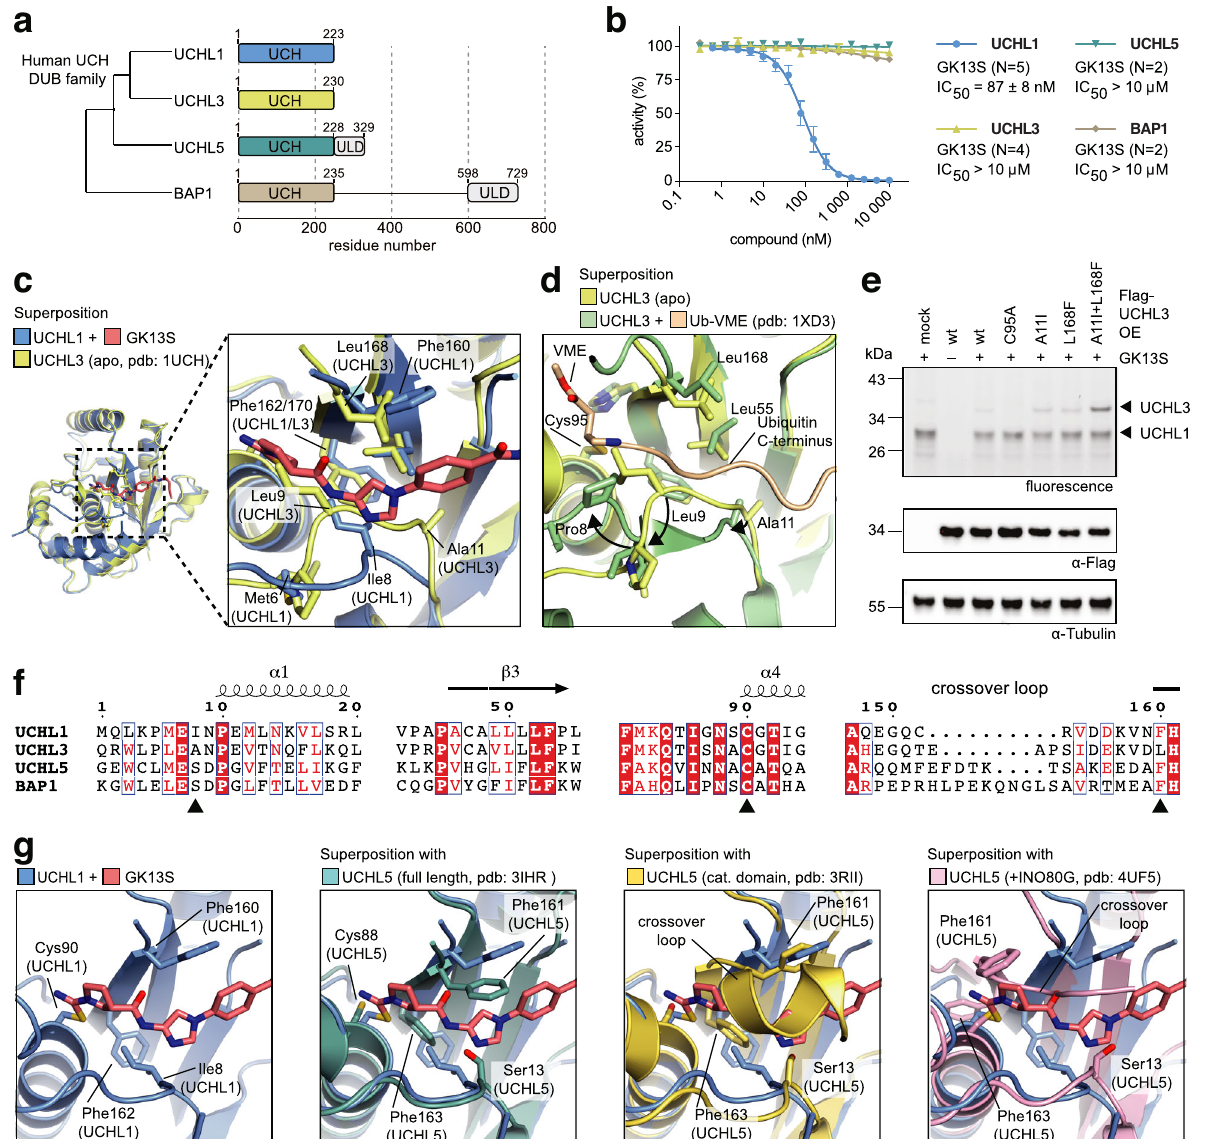
Fig. 6 | Structural basis for speci fi c inhibition of UCHL1. a Average distance alignment and schematic representation of domain architecture of human UCH family deubiquitinases. Boundaries of bacterially expressed UCH catalytic domain constructs are given. ULD, UCH37-like domain. b Ubiquitin rhodamine cleavage assayof indicated recombinant UCH DUBs, preincubated with GK13S dilutions for 1h. Data points are shown as mean±standard error from N =2 – 5 independent experiments, as indicated in the fi gure. Source data are provided asa Source Data fi le. c Superposition of UCHL1~GK13S with apo UCHL1 (pdb: 2ETL) and apo UCHL3 (pdb: 1UCH) and close-up view of the binding pocket. Labeled residues are shown assticks. d Superpositionoftheequivalenttothecompoundbindingpocketinapo UCHL3 and UCHL3~Ub-VME (pdb: 1XD3). The Ubiquitin C-terminus is shown in cartoon representation. Residues undergoing a conformational change upon